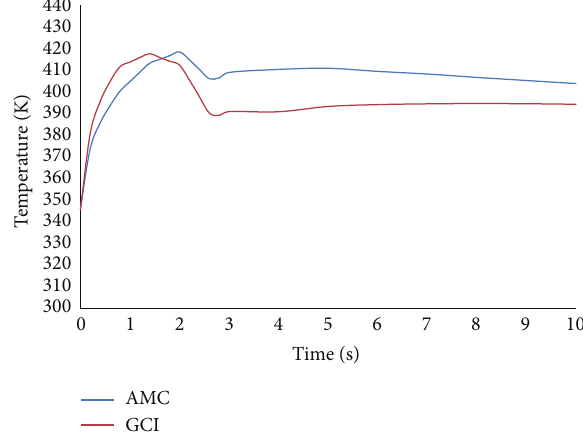
Figure 11: Temperature versus time plots asbestos brake pad and GCI and AMC brake